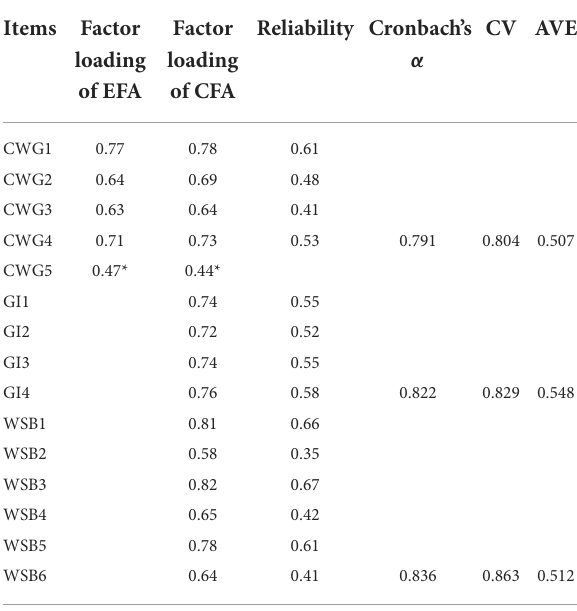
TABLE 4 Results of EFA and